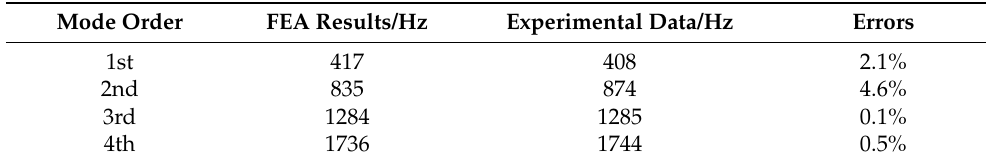
Table 3. Comparison between FEA results and experimental data.